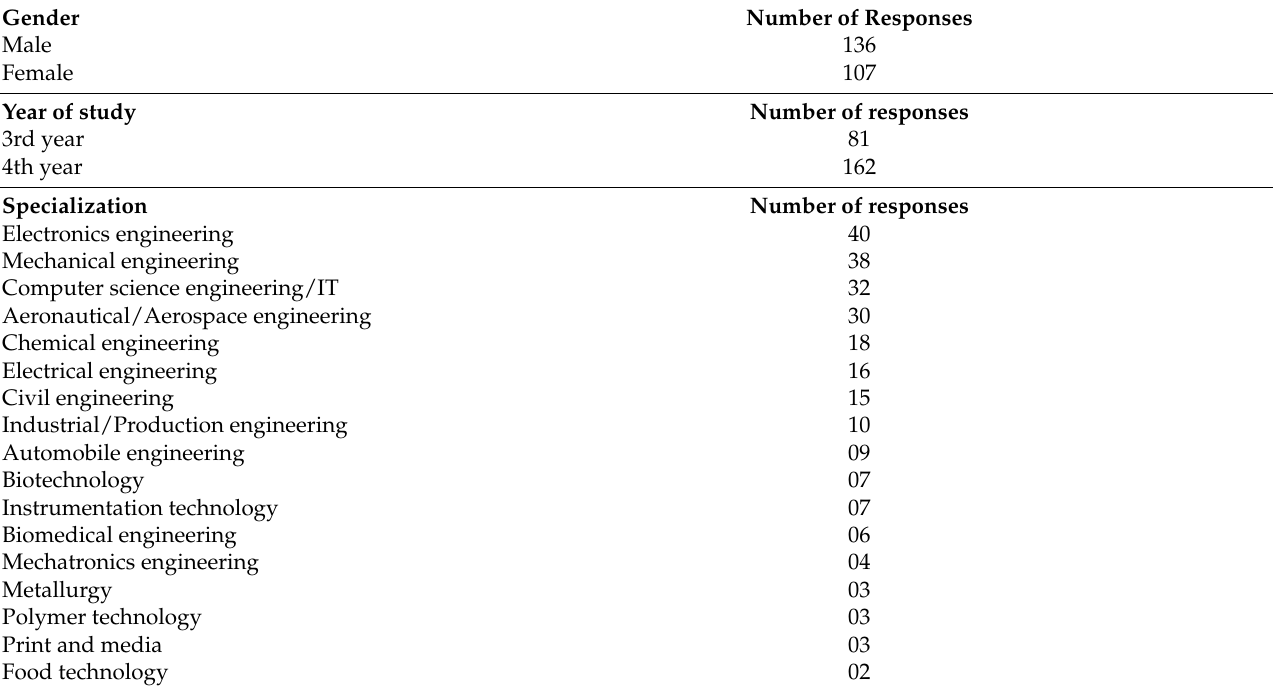
Table 1. Demographic Information of respondents.